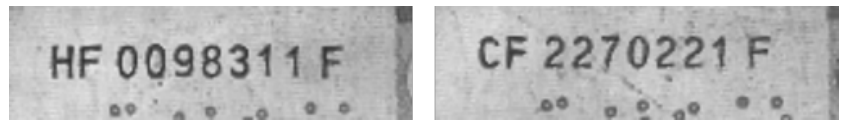
Figure 10. Typical images from set C: 10,000 Won.